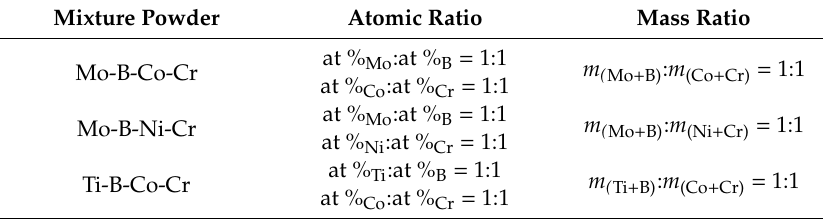
Figure 3. The phase compositions of the powders: ( a ) Mo, ( b ) Co, ( c ) Cr, ( d ) Ni, and ( e ) Ti. Table 1. The details matching the mixture powders.